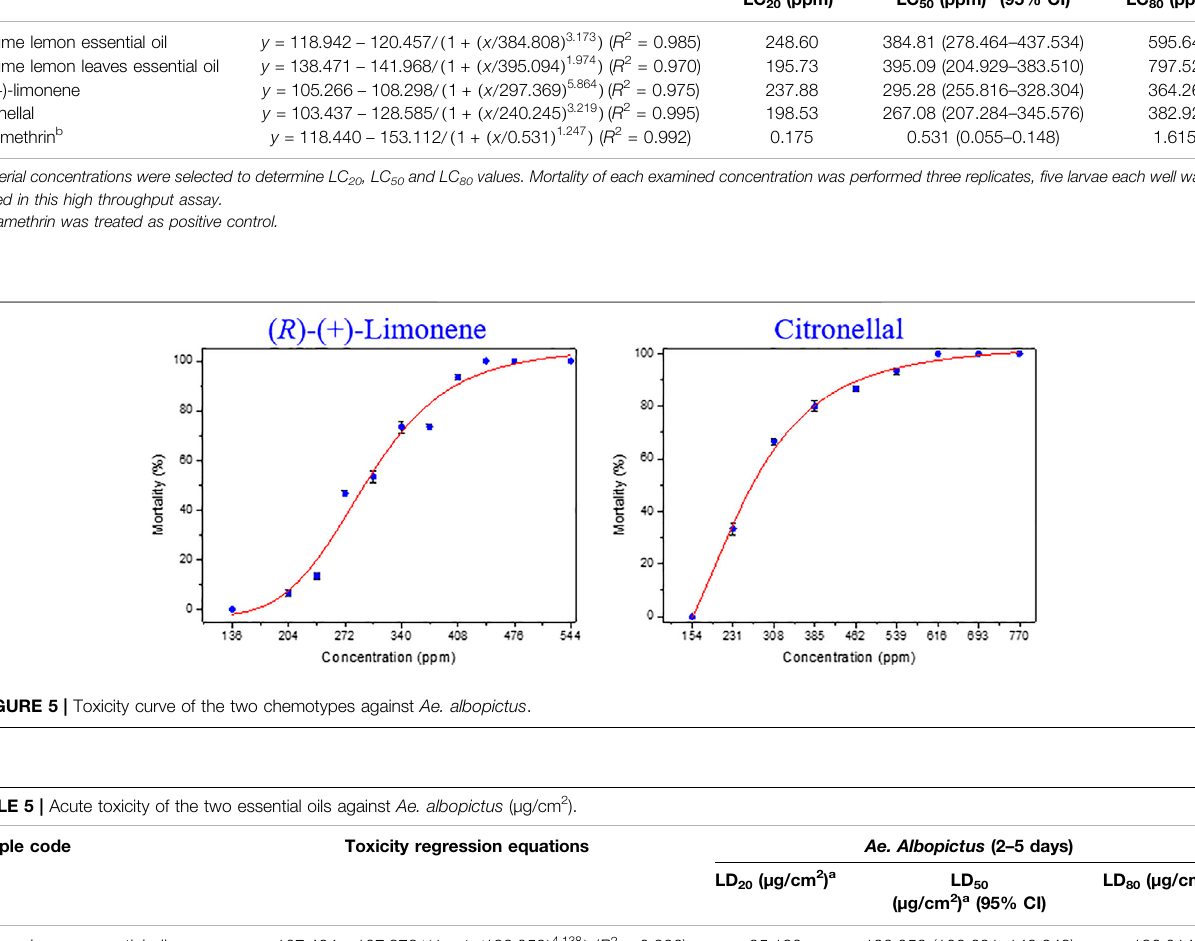
TABLE 4 | Acute toxicity of the two essential oils and two chemotypes against fourth instar larvae of Ae. albopictus (ppm). Sample code